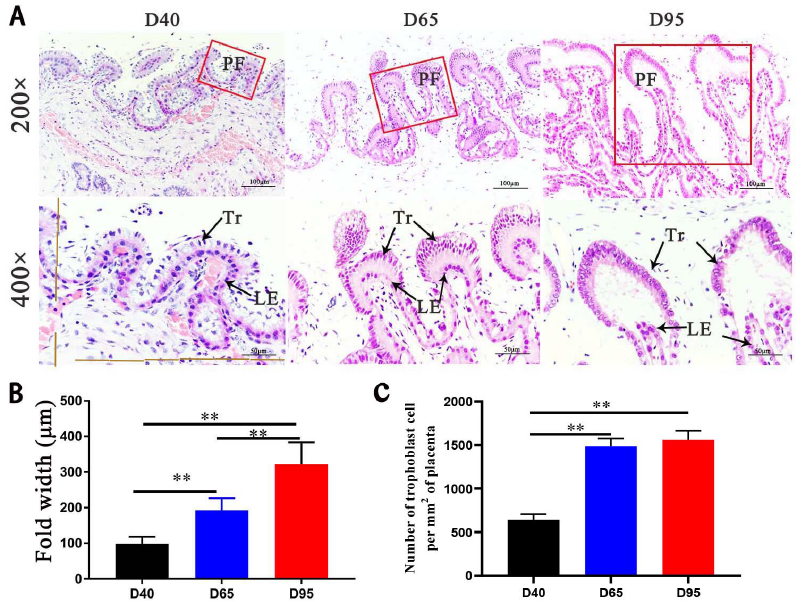
Figure 1. Comparison of placental microscopic folds at different stages of pregnancy. ( A ) Photomi- crographs of representative maternal–fetal interface in pig pregnancies. Placental trophoblast (Tr) attached to endometrial luminal epithelium (LE) to form placental folds (PF). ( B ) The width of the PF and ( C ) the number of trophoblast cell per unit area of placenta were compared using morphometric measurements. ** p < 0.01.